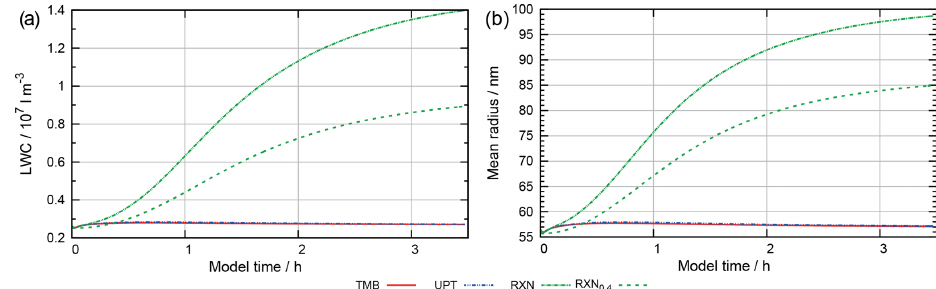
Figure 20. Profiles of the liquid water content (LWC, panel a ) and mean particle radius (b) for the various model runs.